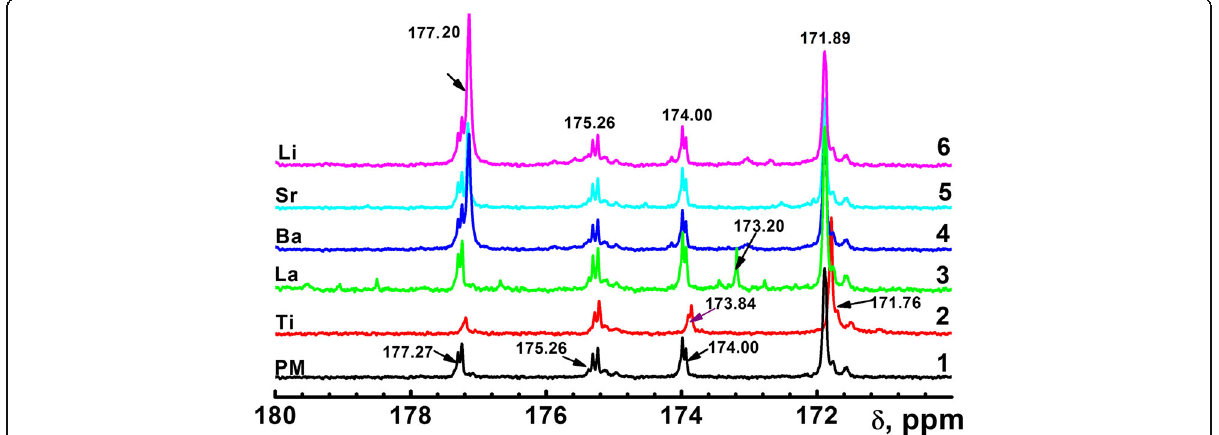
Fig. 1 13C-NMR spectra of the polymer matrix (1) and polymer matrix with metal ions: Ti4+ (2), La3+ (3), Ba2+ (4), Sr2+ (5), Li+